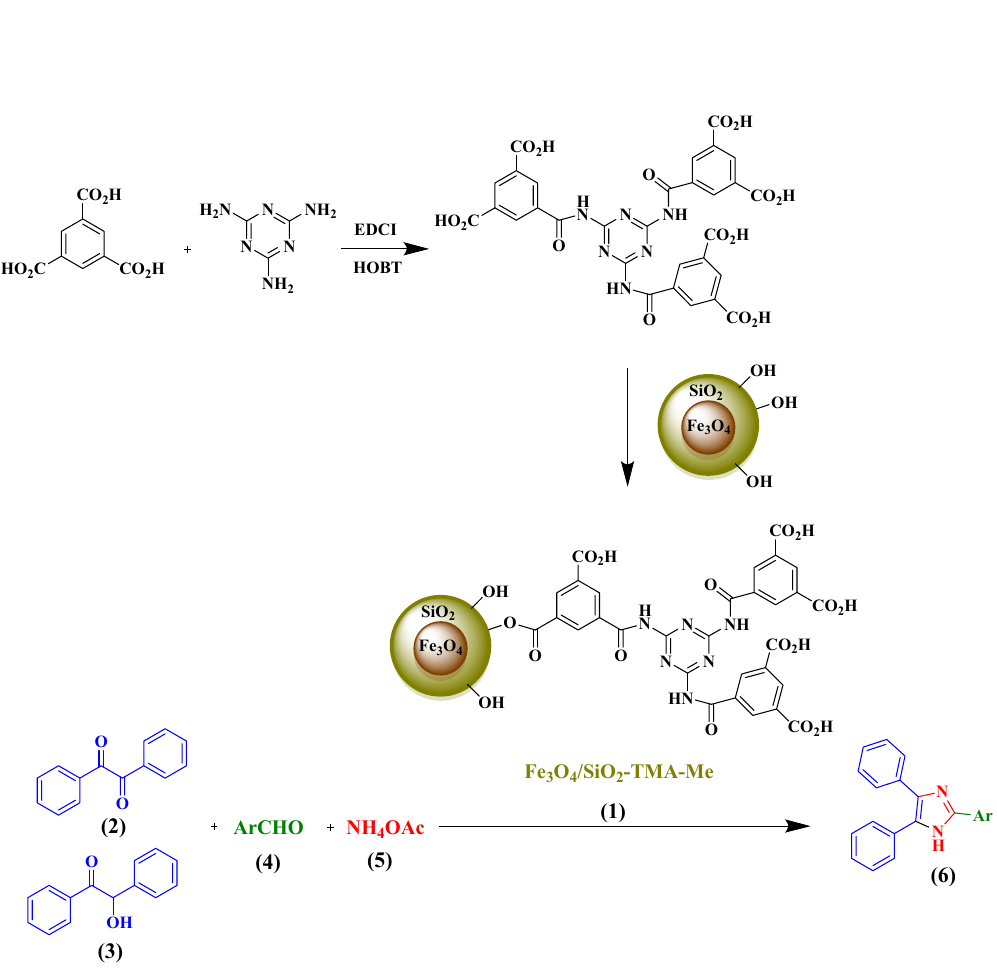
Figure 2. Schematic preparation of the Fe 3 O 4 /SiO 2 -TMA-Me nanocomposite ( 1 ) for the three-component condensation of benzil ( 2 ) or benzoin ( 3 ), aldehydes ( 4 ), and ammonium acetate ( 5 ) to afford imidazole derivatives 6